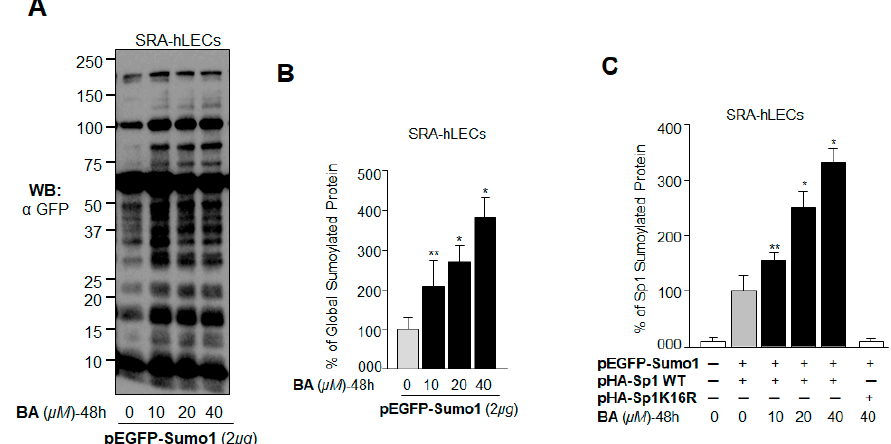
Figure 7. BA promoted aberrant protein Sumoylation in vivo. ( A ) pEGFP-Sumo1 (2 µg) transfected LECs were treated with different concentrations of BA (10–40 µM) for 48 h. Cells were lysed in radio immunoprecipitation assay (RIPA) buffer containing NEM and MG132, and the lysates were separated by sodium dodecyl sulfate polyacrylamide gel electrophoresis (SDS-PAGE), followed by immunoblotting with an anti-GFP antibody. ( B ) The same lysate was used to quantify global Sumoylation protein by Sumo1 ELISA assay. Equal amounts of protein were loaded onto the GFP antibody-coated wells and incubated with the Sumo1 antibody to quantify the level of Sumoylated protein. ( C ) Increased Sp1 Sumoylation by BA in vivo. LECs cotransfected with either pEGFP-Sumo1 plus Sp1 or pEGFP-Sumo1 plus Sp1K16R were treated with different concentrations of BA for 48 h as indicated. A sensitive Sumo1-ELISA assay was used to quantify exogenous Sp1 Sumoylation levels using anti-hemagglutinin (HA) as described in Materials and Methods. The data represent mean ± SD from three independent experiments (** p < 0.05; * p < 0.001).